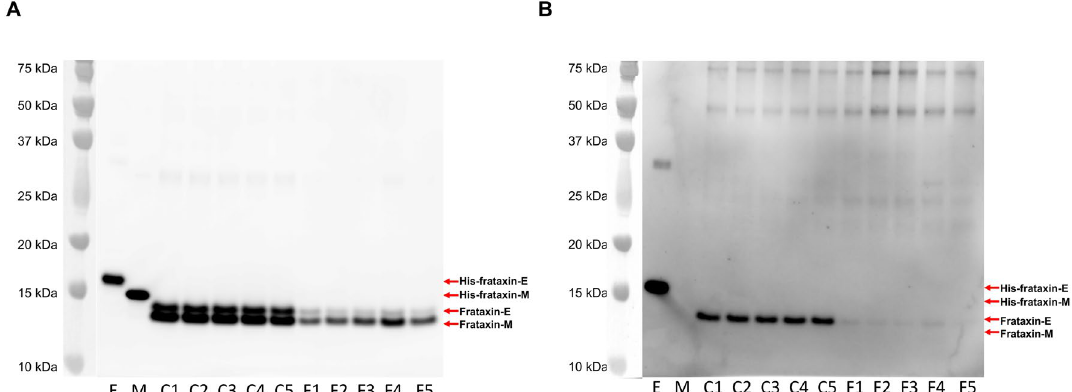
Figure 2. Frataxin-E is deficient in FRDA. Western blot analysis utilizing ( A ) a commercial anti-frataxin monoclonal antibody and ( B ) a specific anti-frataxin-E monoclonal antibody. Blood samples from n = 5 non- FRDA controls (C1 to C5; 0.3 mL) and n = 5 FRDA patients (F1 to F5; 0.5 mL) were immunopurified with anti-frataxin antibody and analyzed via western blot. Lanes “E” and “M” show results for histidine-tagged/ purified frataxin-E and frataxin-M protein, respectively. Arrows and labels (right-hand side) show location of proteins of interest. Although there is a small difference in size (Δ 685 Da) between endogenous frataxin-E (MW = 14,953 Da) and frataxin-M (14,268 Da), these proteins were resolved on PAGE using MES and SDS as the running buffer. Frataxin-E and frataxin M together with their His-tagged standards were detected by the anti-frataxin antibody; whereas, only frataxin-E and His-frataxin E were detected by the anti-frataxin-E mAb. Protein plus protein dual color standards were run on each gel and visualized in black and white by the ImageQuant LAS 4000 camera. Western blots of the frataxin proteins were visualized separately by the camera using the SuperSignal West femto luminol enhancement reagent. The two separate images were then